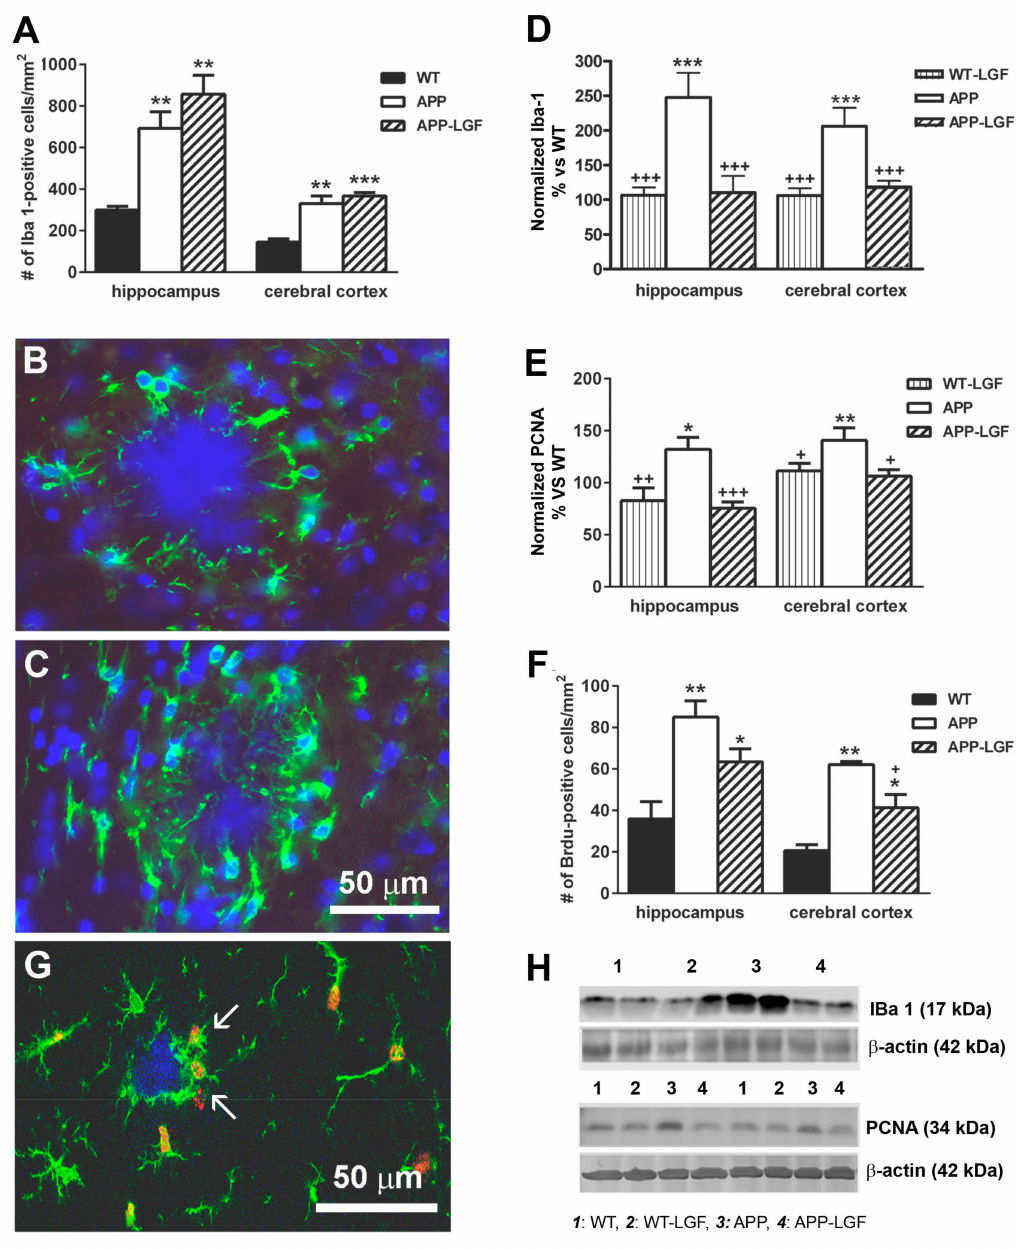
Figure 4. Liver growth factor modulates microglia cell activity in the hippocampus and cerebral cortex of APPswe mice. Panel ( A ) shows the quantification of Iba1-positive microglia cells in APPswe mice. Panels ( B , C ) show di ff erent responses of Iba1-positive cells: in ( B ) microglial prolongations do not penetrate inside the deposit, while in ( C ) they actively phagocytize the plaque (scale bar: 50 µ m). Panels ( D , E ) show quantitative Western blot analysis of Iba1 ( D ) and PCNA ( E ) protein expression. Note how LGF administration significantly reduces the over-expression of Iba1 ( D ) and PCNA ( E ) in the hippocampus and cerebral cortex. LGF also reduces BrdU cell incorporation ( F ) as an index of cellular proliferation. Note how BrdU ( G , red) is associated with Iba1-positive cells ( G , green, white arrows). Panel ( H ) show representative Western blots of Iba1 and PCNA and their respective β -actin as charge control. The results represent the mean ± SEM of 4 ( A , F ) and 8 to 10 ( D , E ). independent mice. The statistical analysis was performed by one-way ANOVA followed by Newman–Keuls test. * p ≤ 0.05, ** p ≤ 0.01, *** p ≤ 0.001 vs. WT. + p ≤ 0.05, ++ p ≤ 0.01, +++ p ≤ 0.001 vs. APPswe